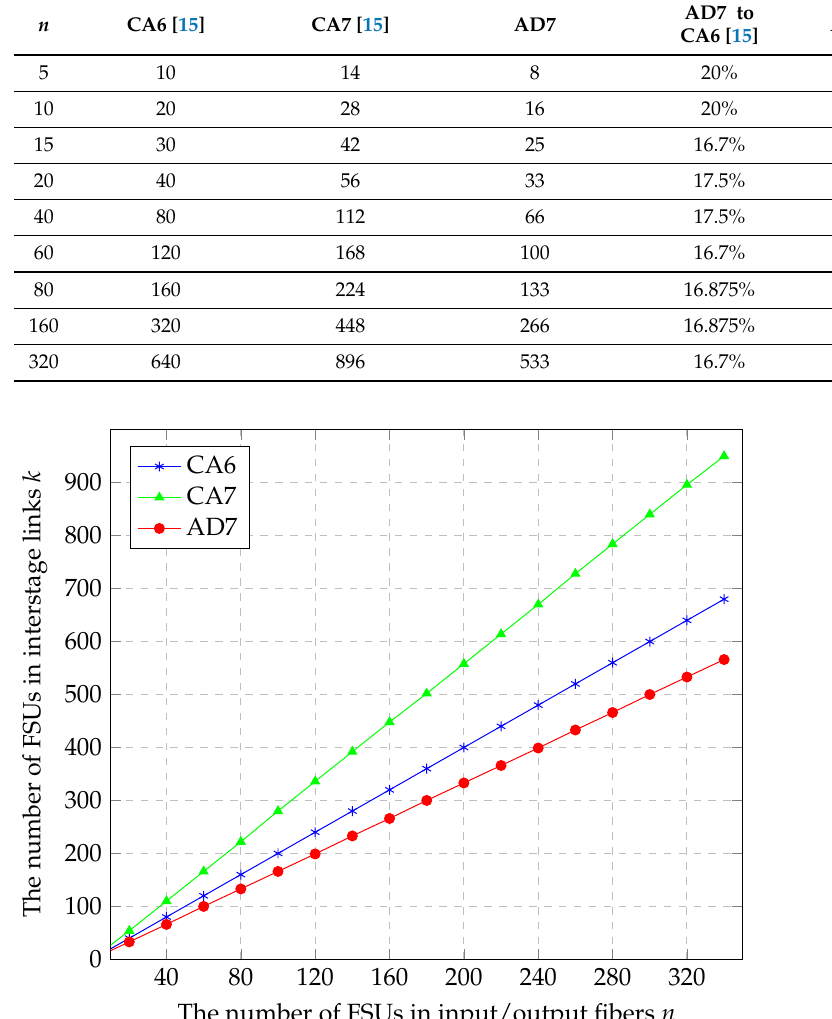
Figure 7. Comparison of k 4 × 4